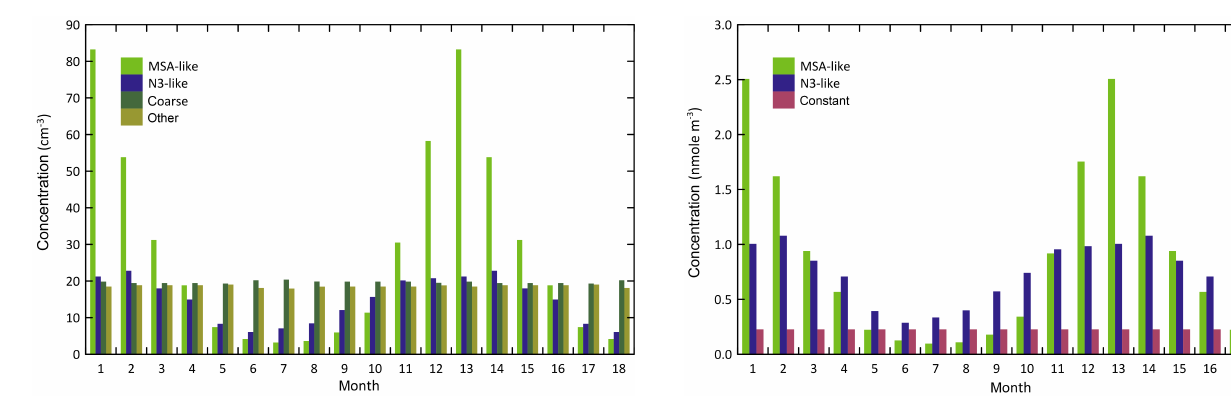
Figure 12. Multiple linear regression for CCN at 0.5% supersatu- ration as a function of four parameters.